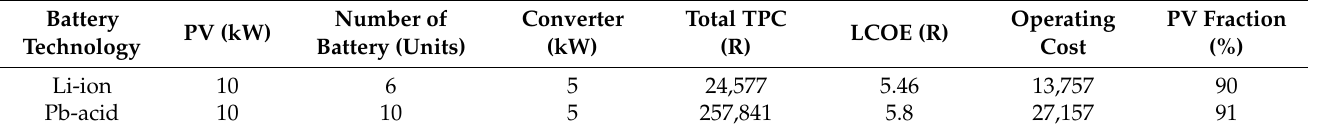
Table 7. Pb-acid vs. Li-ion battery technology in reference to various measure of effectiveness.